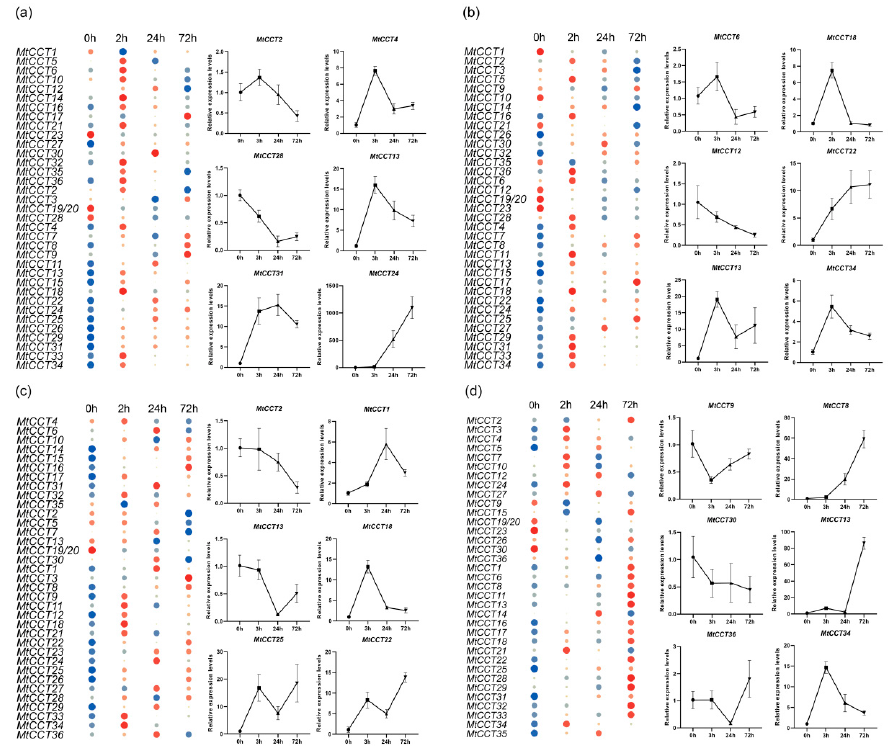
Figure 6. Expression of MtCCT genes in response to different hormones. Plants with fourth blade were treated with 1mM IAA ( a ), 1mM GA 4 ( b ), 1mM SA ( c ) and 1mM ABA ( d ). Expression levels are normalized to MtACTIN and error bars indicate standard deviation among three biological